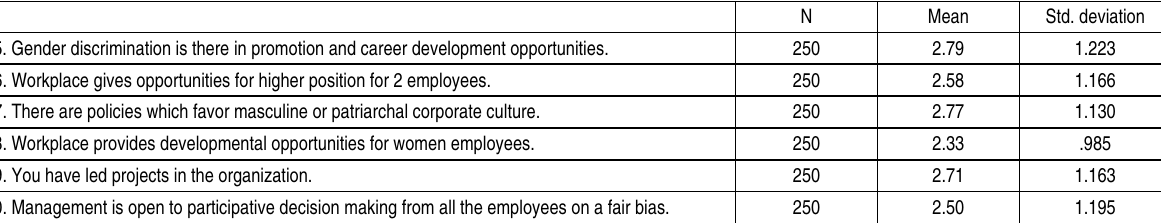
Table 9. Obstacles to gender